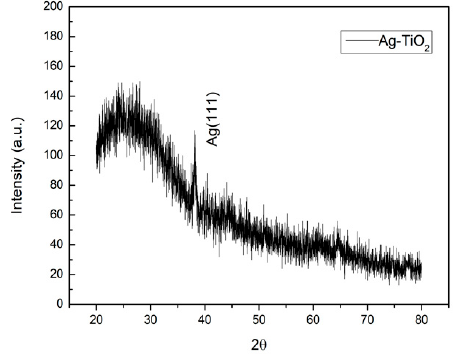
Figure 2. The X-ray diffraction pattern of the Ag-TiO 2 composite.